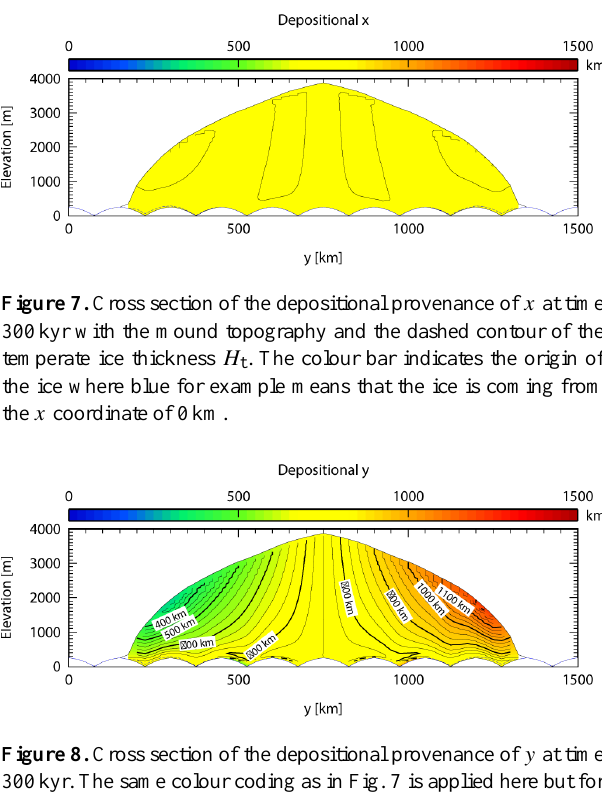
Figure 8. Cross section of the depositional provenance of y at time 300kyr. The same colour coding as in Fig. 7 is applied here but for the y coordinate.